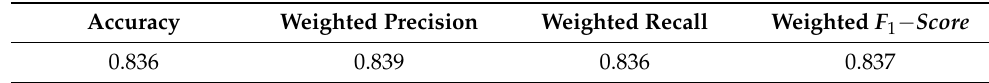
Table 6. Classification accuracy using FinBERT.